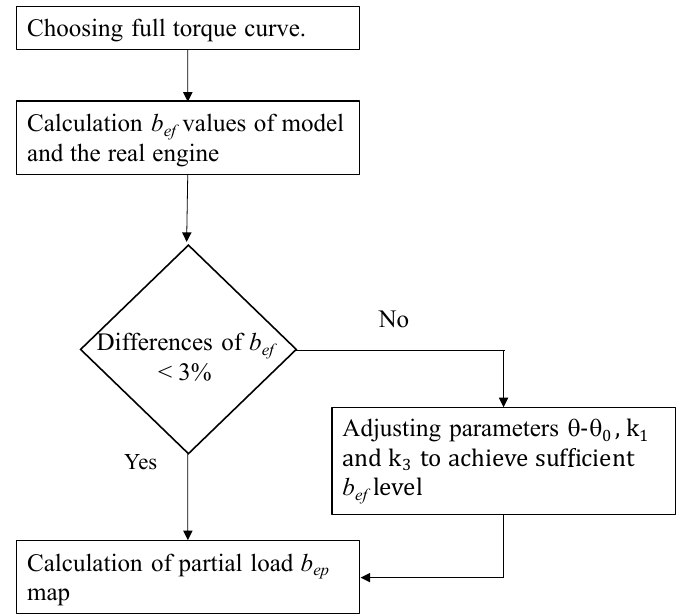
Figure 2. Calculation procedure structure and parameter calibration.